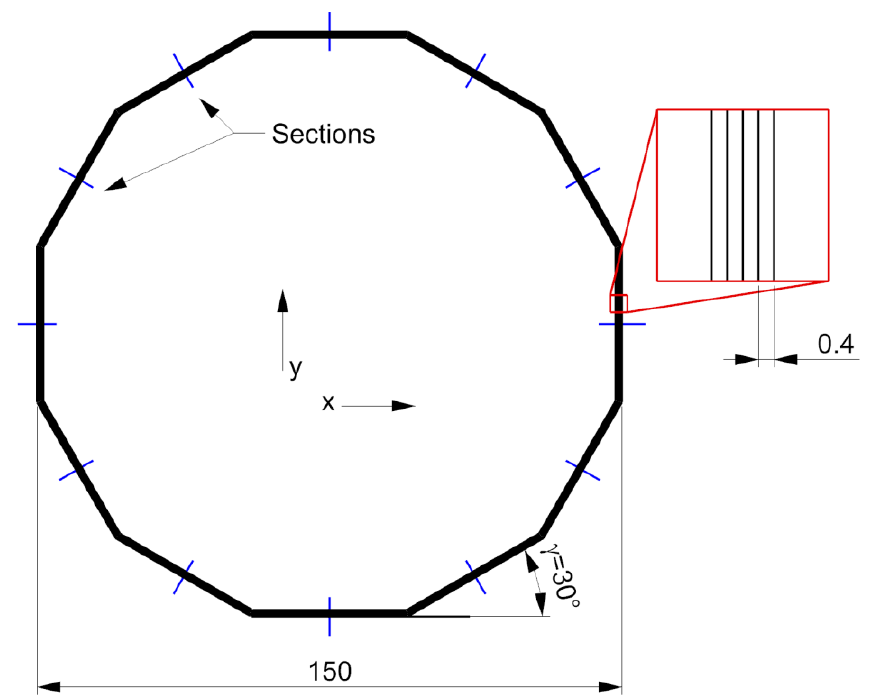
Figure 6. Deposited section studied.